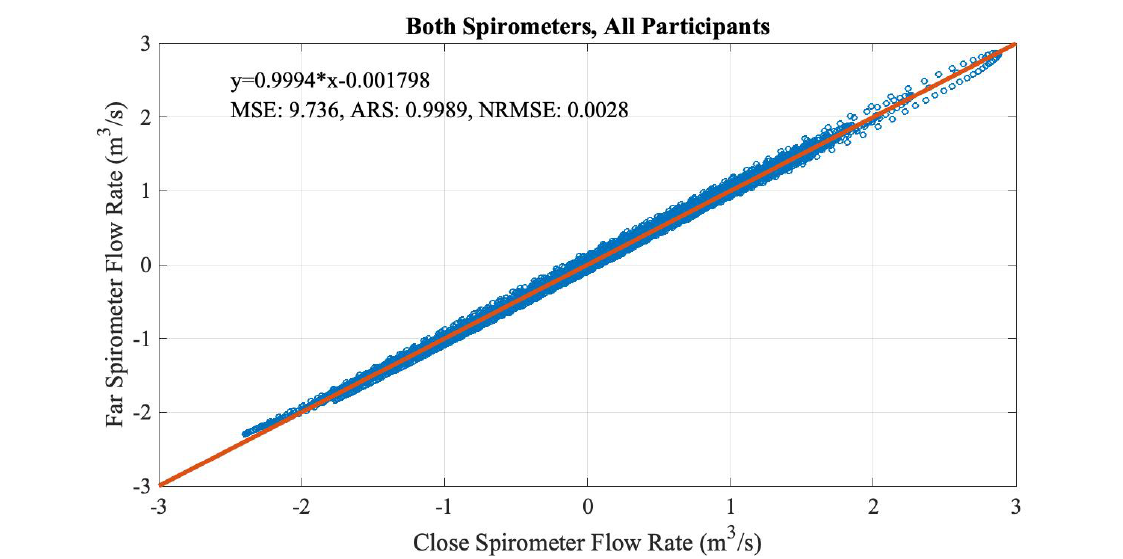
Figure 7. The correlation of The flow rate data from both spirometers in The S2S setting, all participants